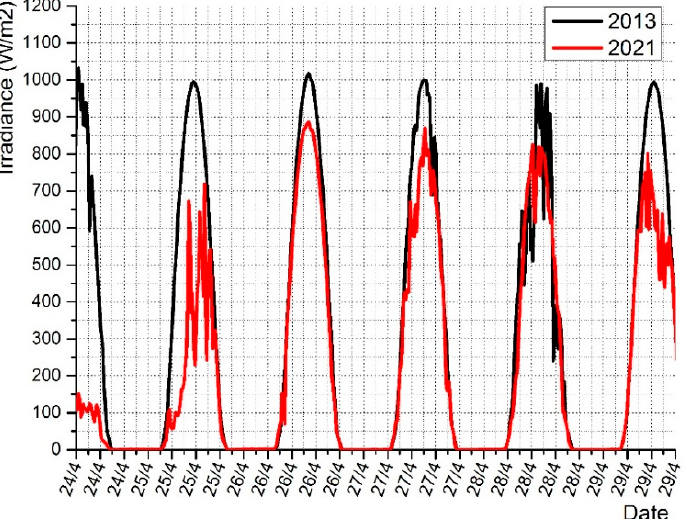
Figure 15. Comparison of measured Irradiance of 2013 and 2021 in correlation with airmass.